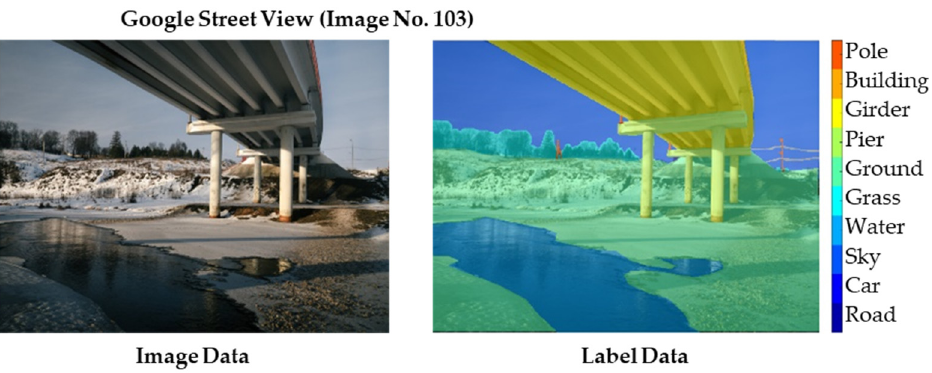
Figure 7. Google street view images and labels.